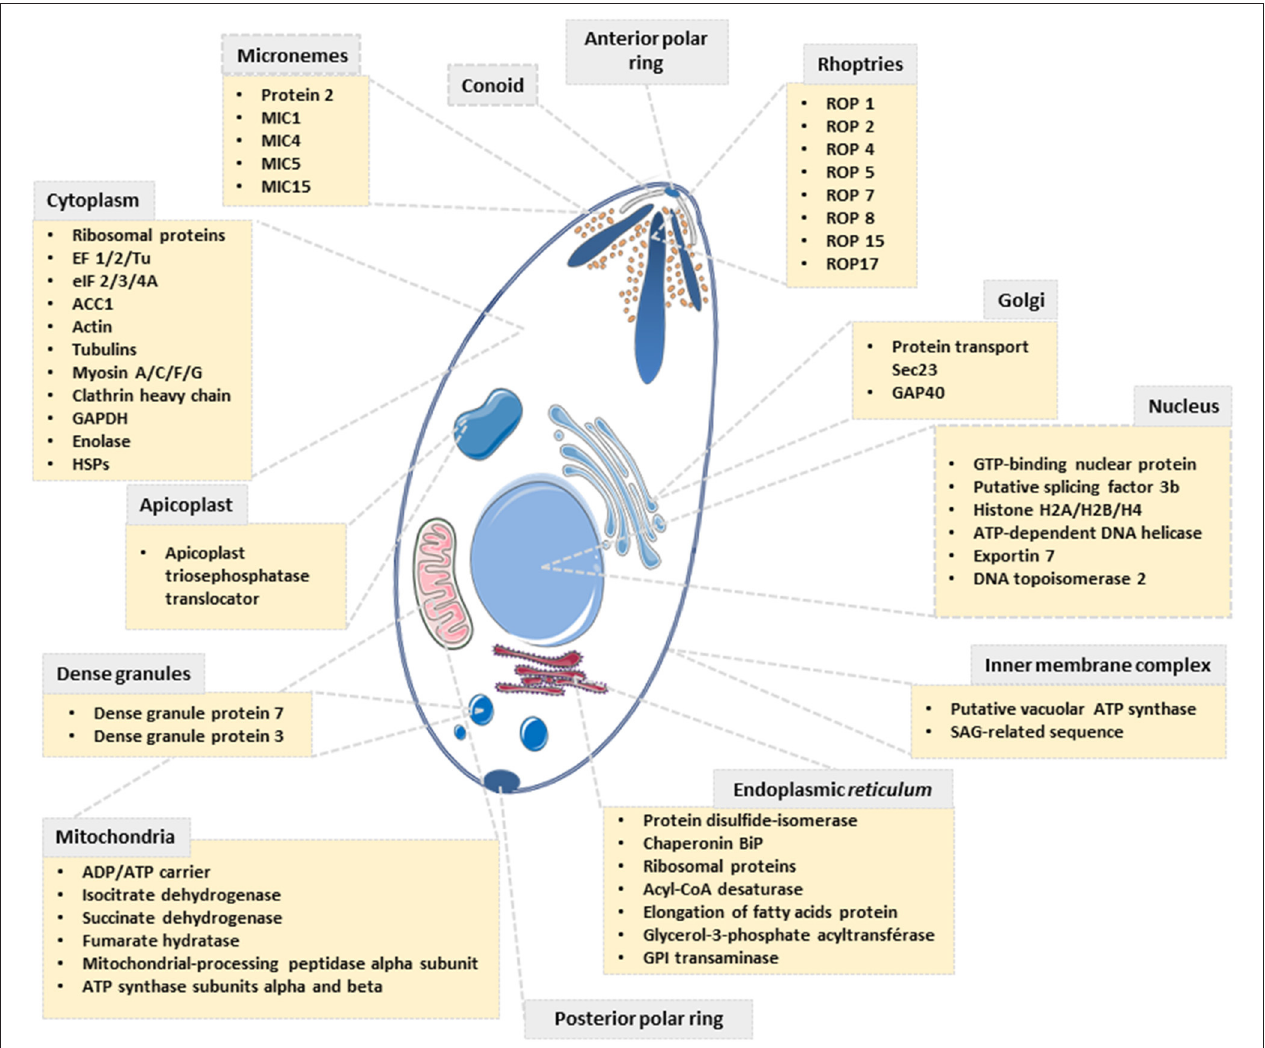
FIGURE 4 | Scheme depicting the subcellular localization of proteins identified to be O -GlcNAcylated in T. gondii .